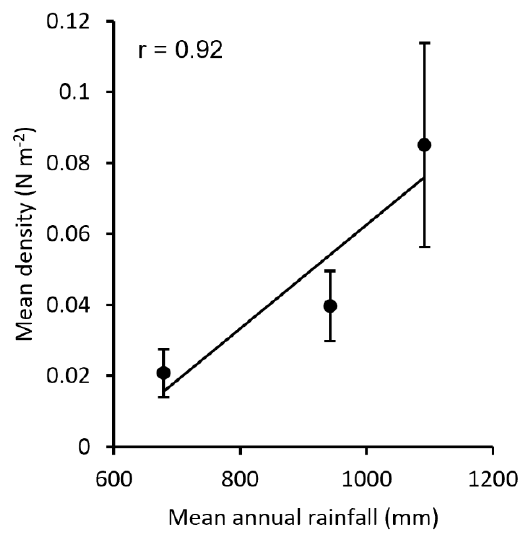
Figure 8. Correlation of the A. mediterraneus mean density (± SE) in the three considered macro-areas vs. the mean annual rainfall in the area.